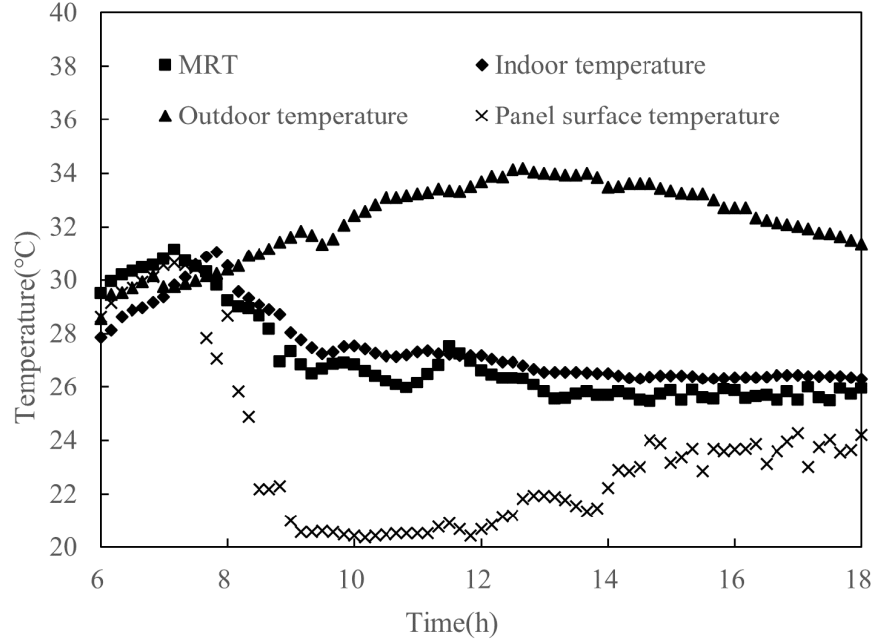
Figure 15. Variation process of MRT, indoor temperature, and surface temperature of radiant panel with time, under constant temperature control.